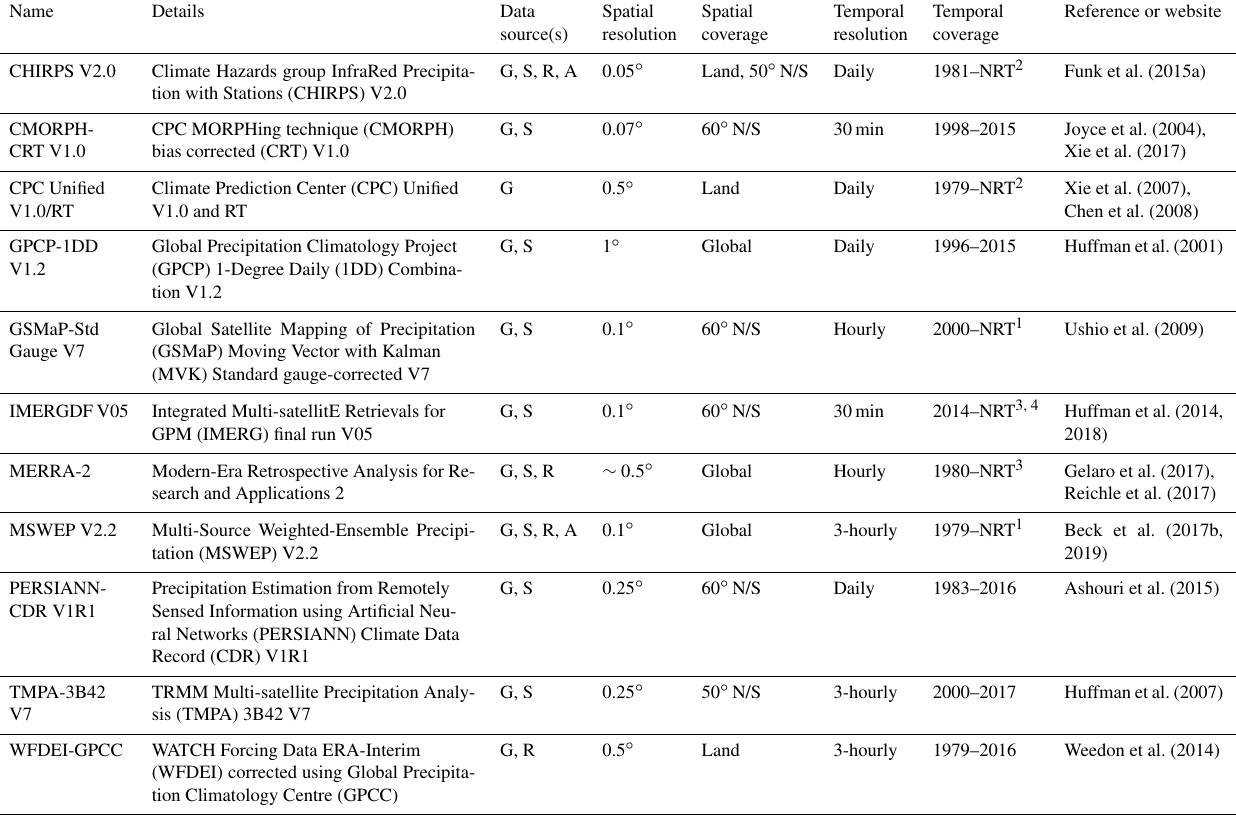
Table 2. Overview of the 11 gauge-corrected (quasi-)global (sub-)daily gridded P datasets evaluated in this study. The 15 uncorrected datasets are listed in Table 1. Abbreviations in the data source(s) column defined as G, gauge; S, satellite; R, reanalysis; and A, analysis. The abbreviation NRT in the temporal coverage column stands for near real time. In the spatial coverage column, “global” indicates fully global coverage including ocean areas, while “land” indicates that the coverage is limited to the terrestrial